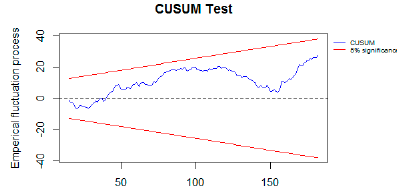
Figure 2. Cumulative sum ( CUSUM) test of butter.